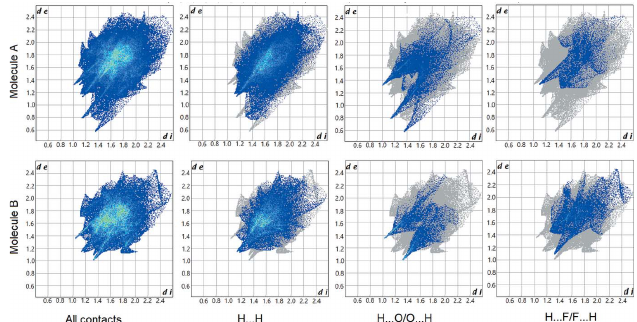
Figure 4 Two-dimensional fingerprint plots for ( a ) all interactions and delineated into ( b ) H (cid:2)(cid:2)(cid:2) H, ( c ) H (cid:2)(cid:2)(cid:2) O/O (cid:2)(cid:2)(cid:2) H and ( d ) H (cid:2)(cid:2)(cid:2) F/F (cid:2)(cid:2)(cid:2) H contacts in molecules A and B .